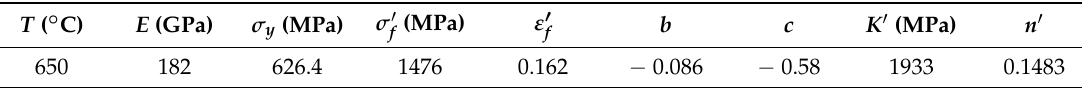
Table 2. Material properties of